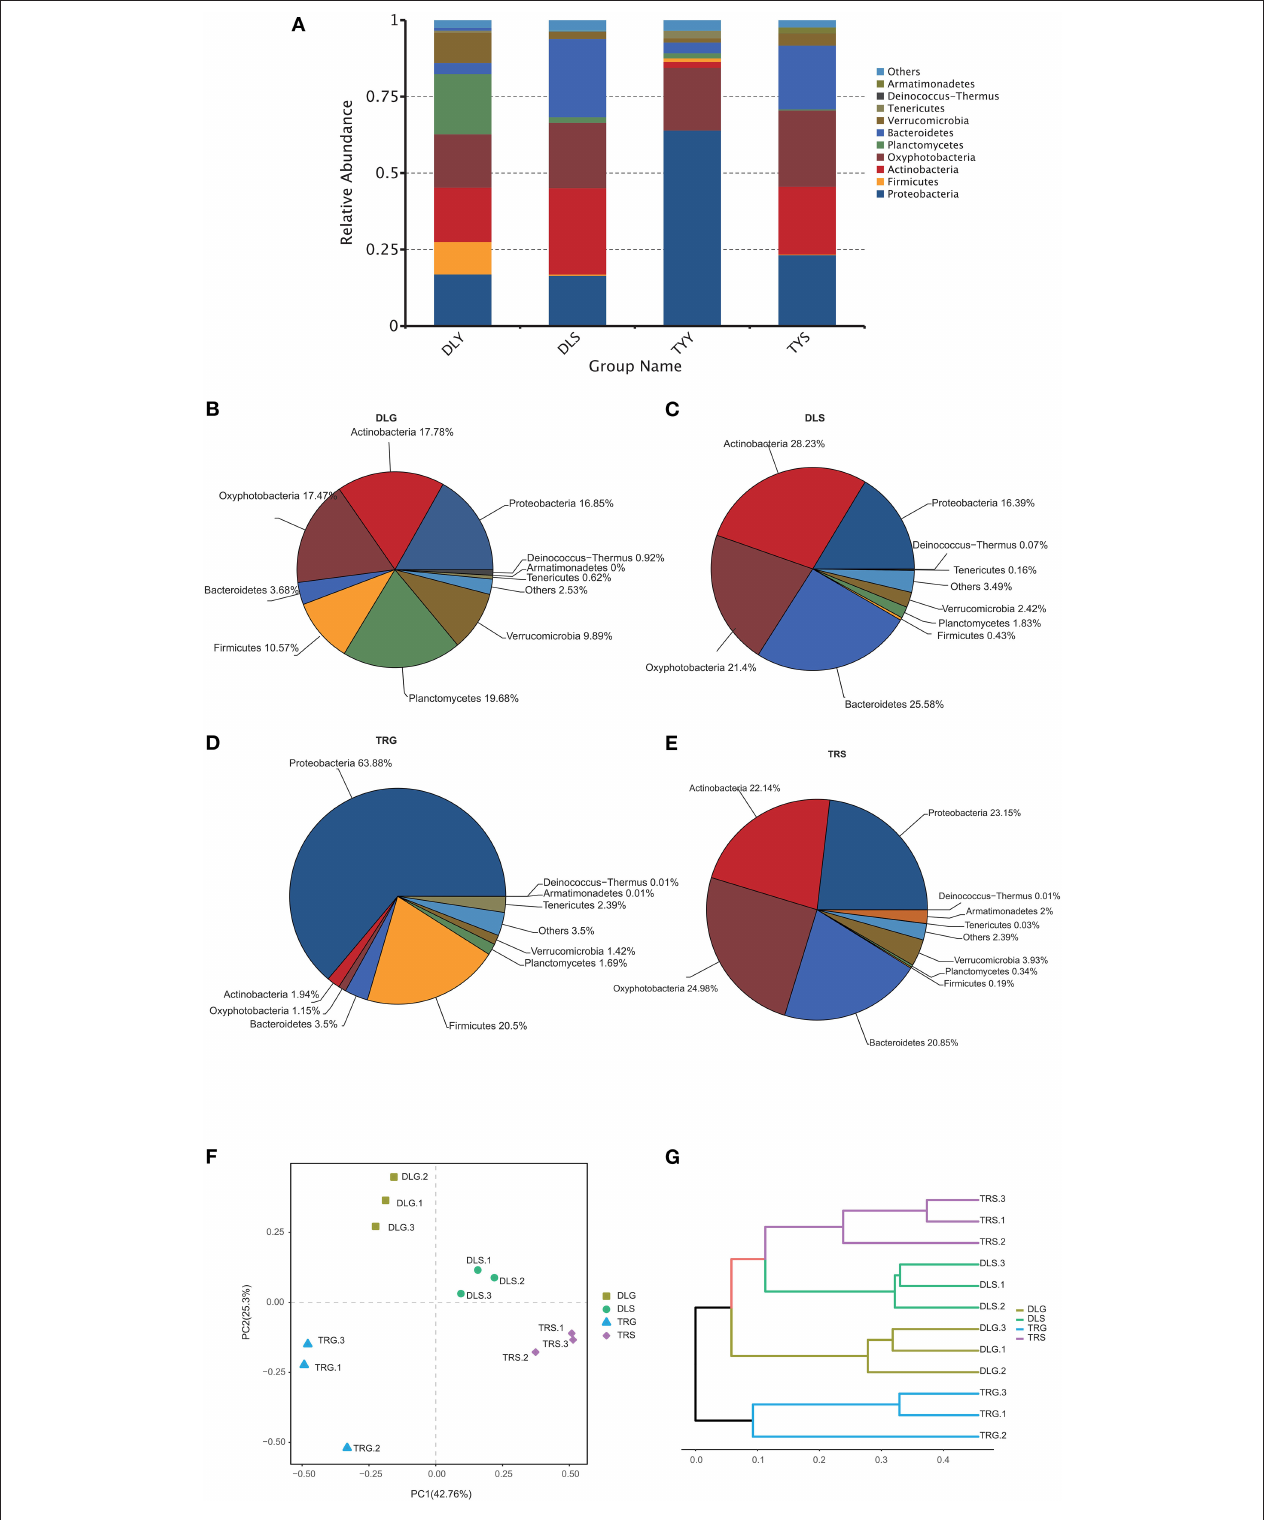
FIGURE 4 | The microbiota composition at the phylum level (A–E) , the principal coordinates analysis (PCoA) of the bacterial community (F) at OTU level, and hierarchical clustering tree (G) in the four groups. Microbiota composition of bacterial taxa at phylum level in the four groups (A) and, respectively, in DLG (B) , DLS (C) , TRG (D) , and TRS (E) . Three samples in each group, each example = 10 fish. The hierarchical clustering tree was calculated using the UPGMA (Unweighted Pair-group Method with Arithmetic Mean) method. The relationship between samples was determined by Bray distance and the average clustering method.